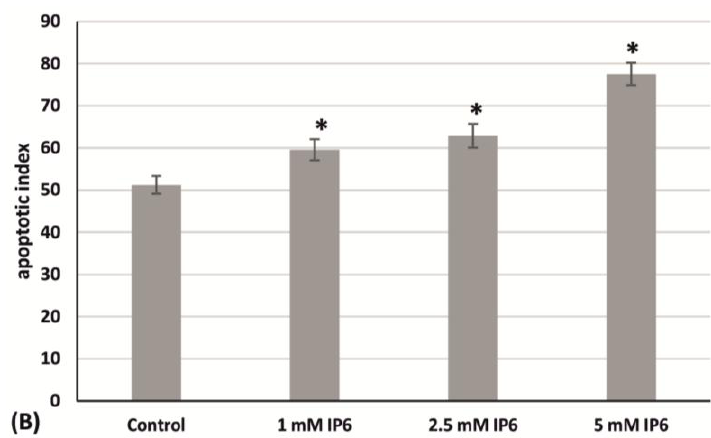
Figure 3. ( A ) Apoptotic and necrotic effect in the control and Caco-2 cells following treatment